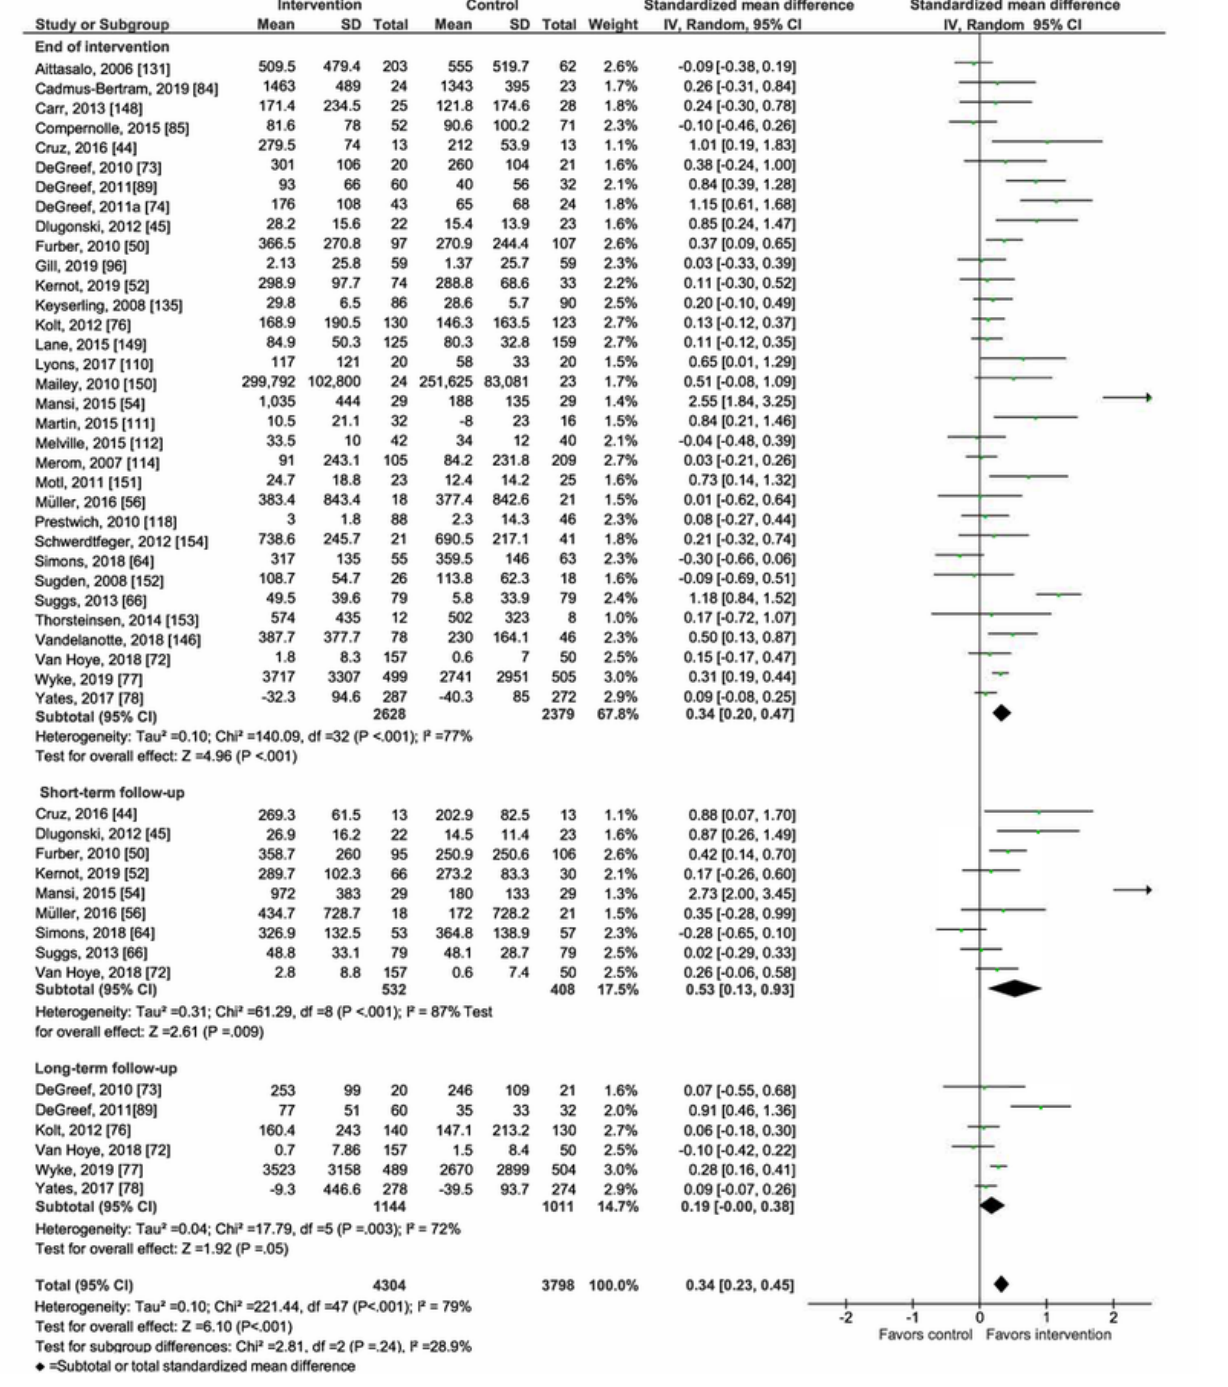
Figure 8. Primary outcome analysis by measurement time point for the outcome total physical